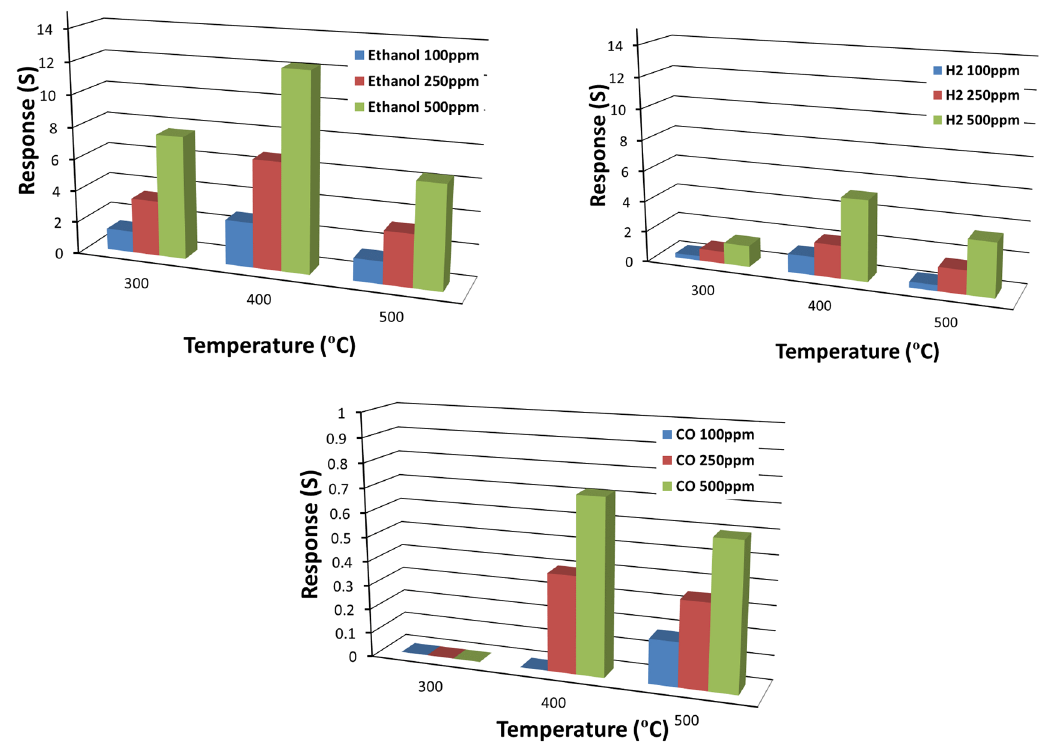
Figure 10. Response towards H 2 , ethanol, and CO in different working temperatures. RH = 40% at 20 °C with applied voltage equal to 1 V.